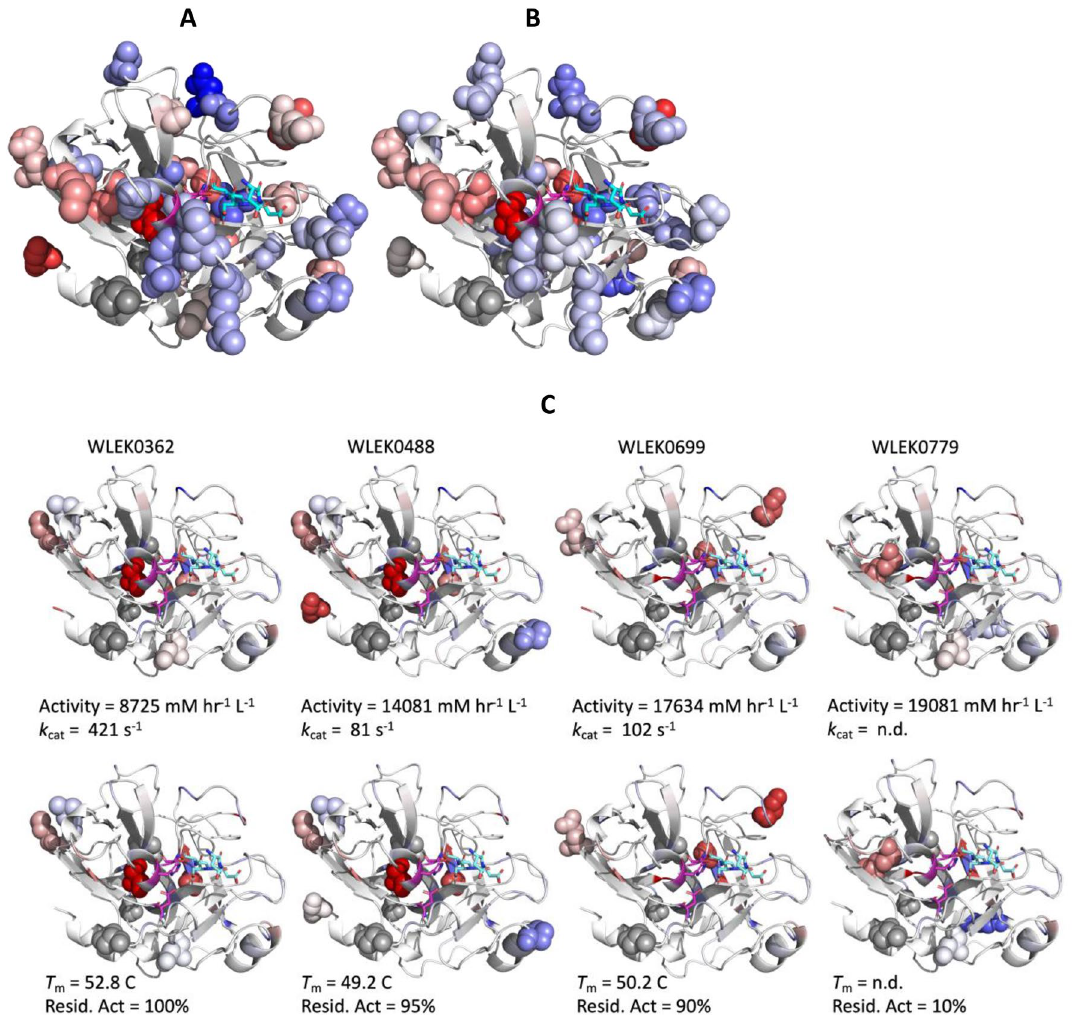
Figure 8. Position in EK L structure of mutations with significant contributions to ( A ) Total activity, ( B ) Residual activity after heat inactivation, and ( C ) Key variants. Colours represent significant PLS coefficients from beneficial (red, 1.5) to deleterious (blue, -1.5) mutations. Sites with no observed mutation or with low PLS coefficients are shown in white. Grey spheres correspond to the positions of mutations in the parent sequence (V15Q, R82P, C112S) used as the backbone for DNA-shuffling. Residues in magenta are the catalytic triad (S187, H41, D92), while those residues in cyan show the DDDK peptide substrate. In Panel C, mutation sites for each variant are highlighted as spheres, and the colours represent PLS coefficients for total activity (top row) and residual activity after heat inactivation (bottom row). Structure was generated from PDBID: